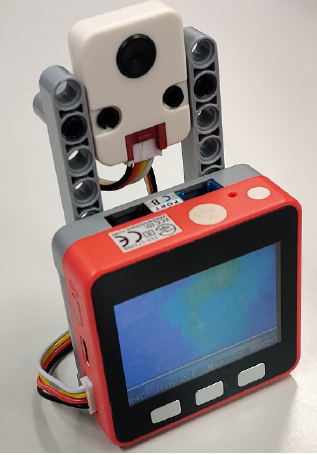
Figure 1. The M5Stack and the infrared array sensor.